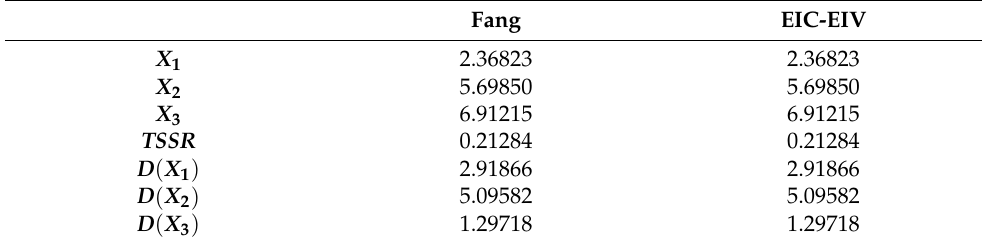
Table 1. Adjustment results of equality